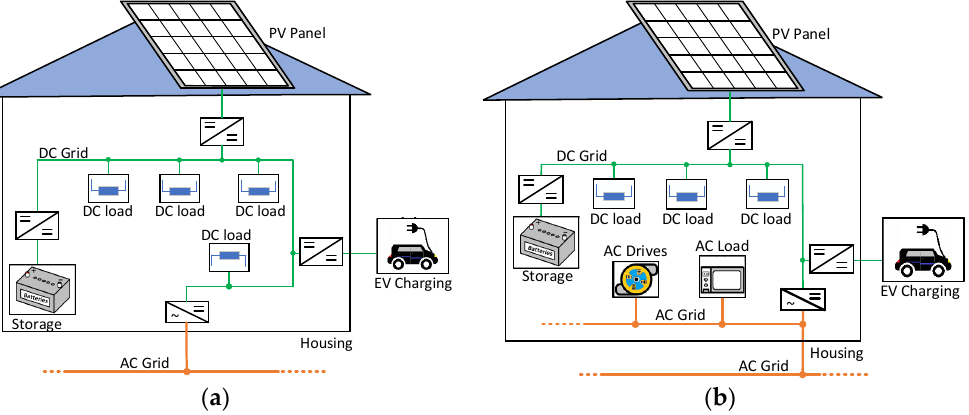
Figure 11. Possible structure of the electrical infrastructure for individual residential level: ( a ) only a DC network and ( b ) parallel infrastructure of AC and DC networks.